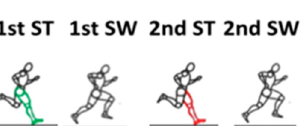
Figure 1. Figure of the running stride cycle sub-cycles: the first stance (1st St), first double float (1st Sw), second stance (2nd St), and second double float (2nd